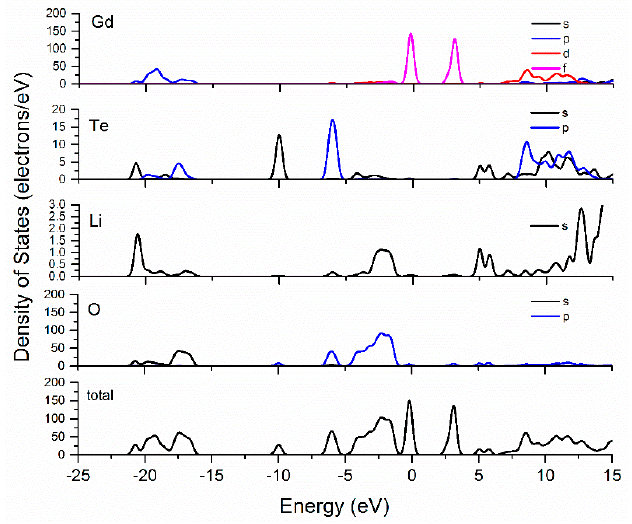
Figure 3. The calculated density of states diagrams for Gd 3 Li 3 Te 2 O 12 . From the top partial density of states is shown for Gd, Te, Li, and O ions, respectively, together with the total density of states.